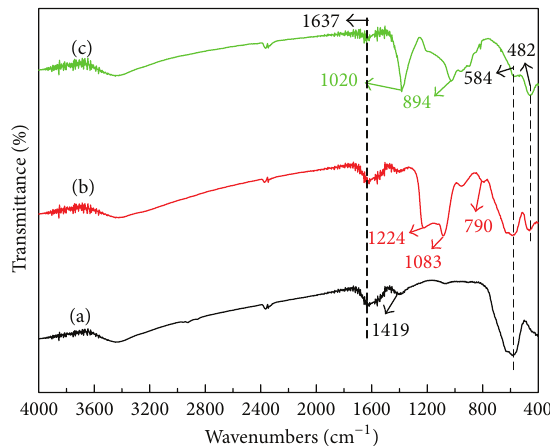
Figure 3: IR spectra of (a) Fe 3 O 4 , (b) Fe 3 O 4 @SiO 2 , and (c) Fe 3 O 4 @SiO 2 /Bi 2 SiO 5 .